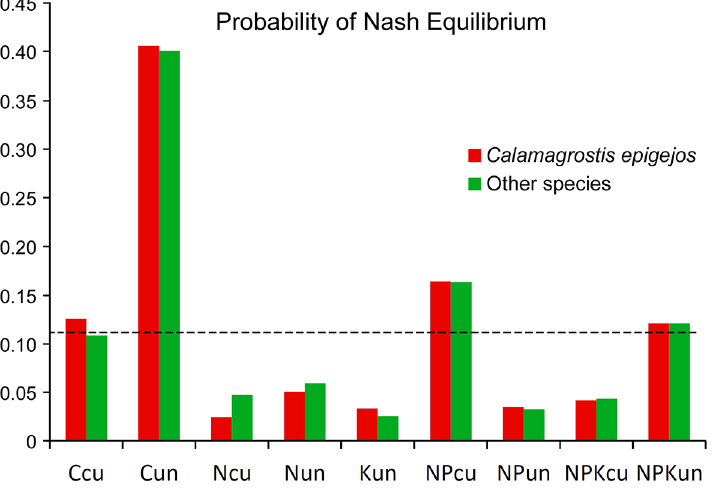
Fig 2. Obtained Nash equilibrium probabilities for individual management treatments. The dotted line is the expected value of 1/9 that corresponds to a uniform distribution of NE probability.